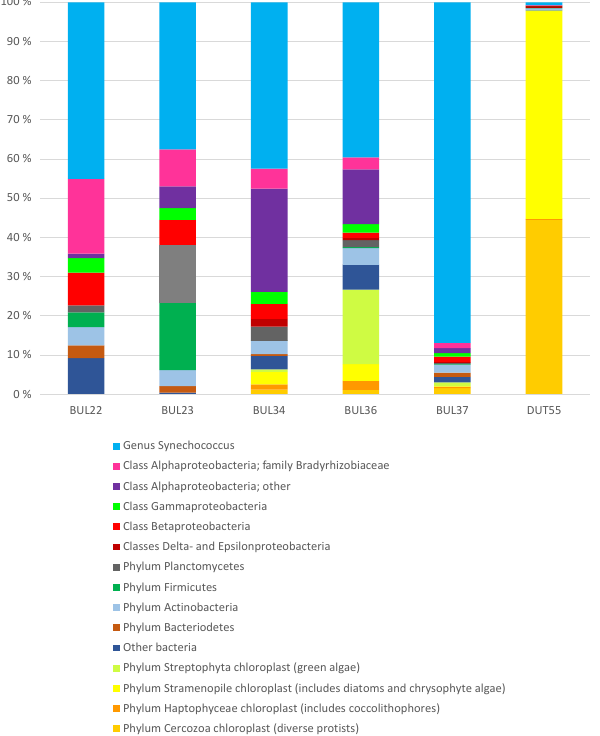
Figure 4. Relative abundance of taxonomically assigned 16S rRNA gene sequences from bacteria and chloroplasts within the cytoplasm of six individual foraminifer specimens: five G. bulloides (BUL22, BUL23, BUL34, BUL36 and BUL37) and one N. dutertrei spec- imen (DUT55). Sequences are assigned to operational taxonomic units (OTUs) grouped at different levels of taxonomic classification (see key). 16S rRNA gene sequences assigned to OTUs of the genus Synechococcus are the most abundant within G. bulloides and are at the highest level of classification when compared to the other OTUs assigned to individual classes or phyla.